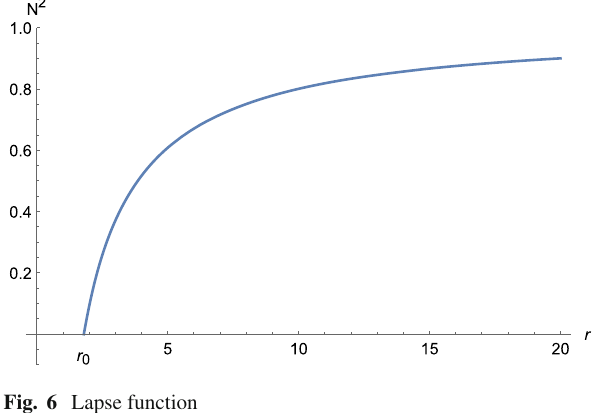
Here, 0 ≤ t < ∞ , and r 0 < r < ∞ , where r 0 , in a solution to the equation X 2 boundaries of (cid:2) − and (cid:2) + ,